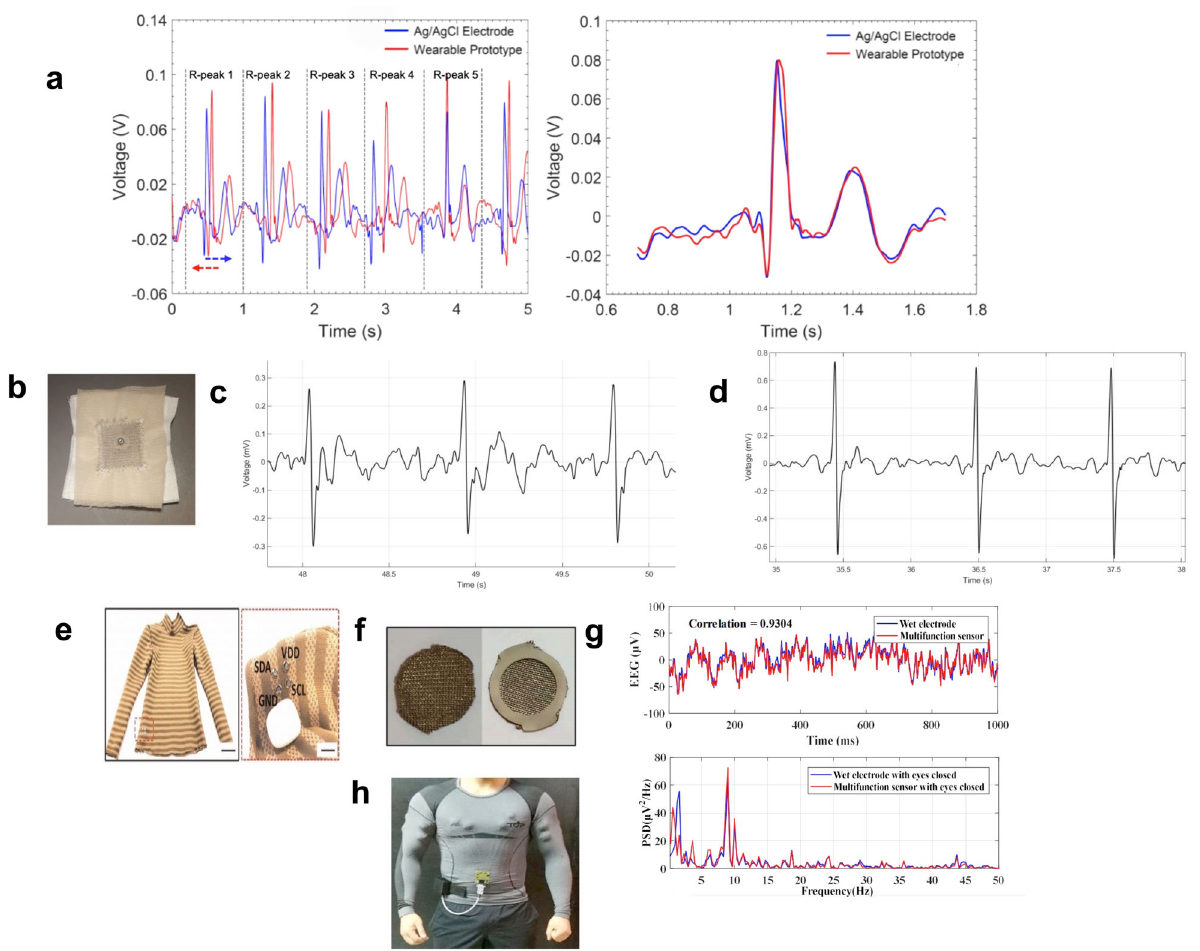
Fig. 2 Textile-based HWDs for measuring vital bio signals for example ECG, EEG, and EMG. a Comparison of ECG signals from Ag/AgCl electrodes and ECG HWD. Reproduced with permission from Yapici et al. 23 Copyright © Sensors, 2017. b Textile-based ECG electrode c , d ECG vs time graphs of the textile-based ECG electrode. Reproduced with permission from Arquilla et al. 25 Copyright © Sensors, 2020. e E-TeCS wearable with sensors on the shirt. Reproduced with permission from Wicaksono et al. 26 Copyright © npj Flexible Electronics, 2020. f Multisensor textile-based electrode for EEG and sweat rate measurement. g Comparison of textile-based electrode, as illustrated in f , with traditional EEG electrode for alpha rhythm detection during eyes closed. Reproduced with permission from Gao et al. 28 Copyright © IEEE Sensors Journal, 2020. h Wearable shirt for the monitoring of EMG. Reproduced with permission from Pino et al. 30 Copyright © IEEE Conference of the IEEE Engineering in Medicine and Biology Society,